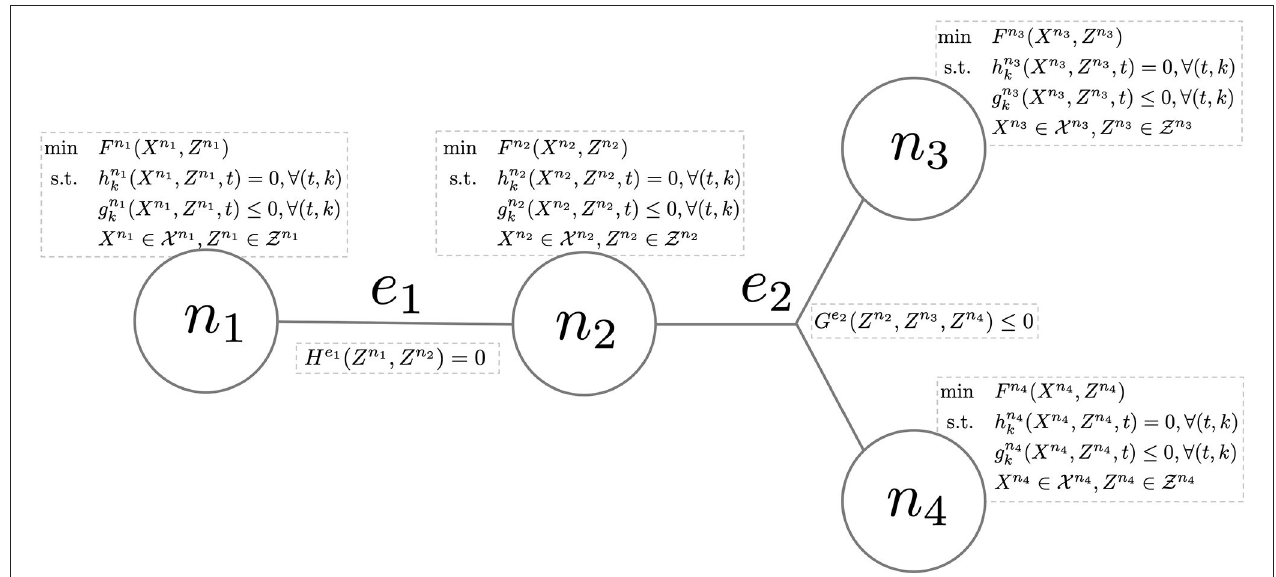
FIGURE 1 | Hypergraph abstraction of a hypothetical problem whose block structure is represented by four nodes (i.e., N = { n 1 , n 2 , n 3 , n 4 } ) and two hyperedges (i.e., E = { e 1 , e 2 } , with e 1 = { n 1 , n 2 } and e 2 = { n 2 , n 3 , n 4 } ). Note that e 1 only has equality constraints while e 2 only has inequality